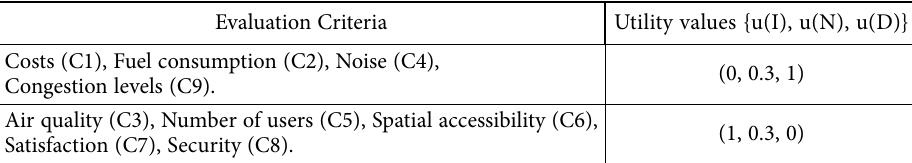
Table 4. Utility values for criteria Evaluation